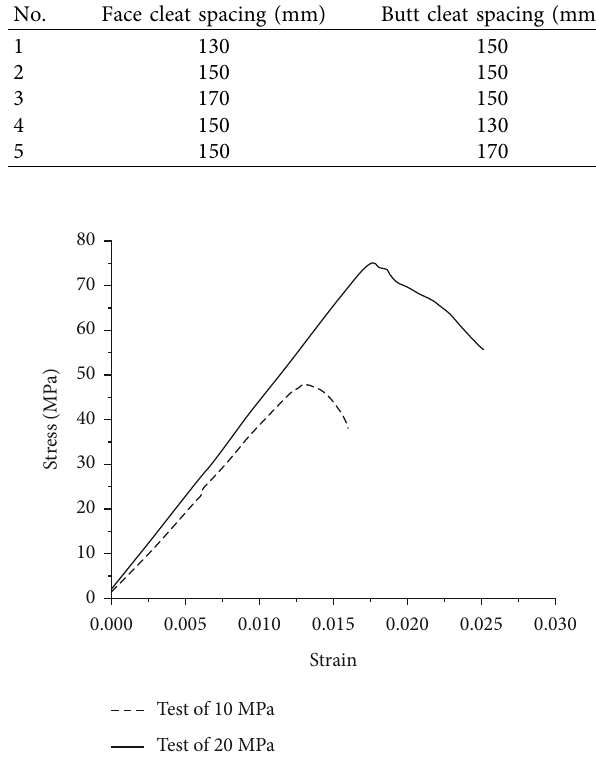
Figure 4: Stress-strain test curves of coal